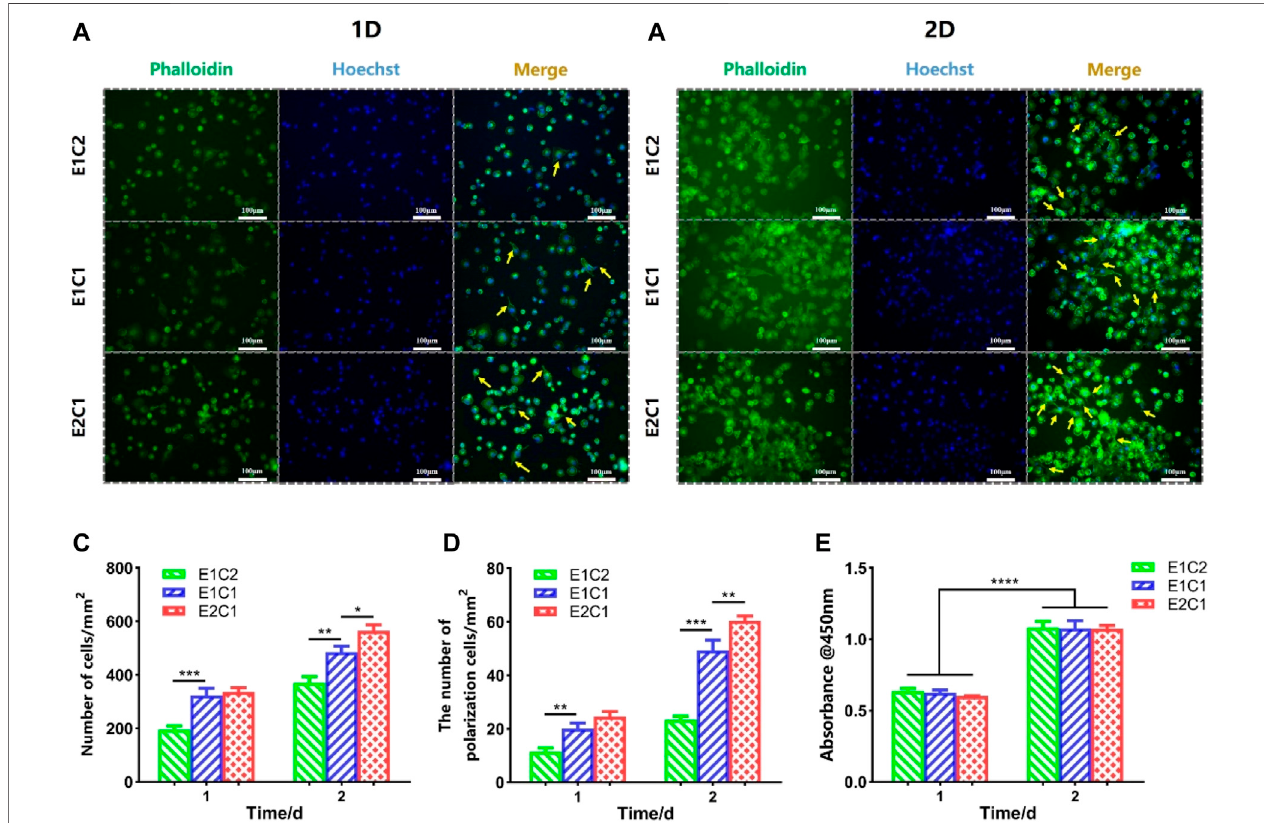
FIGURE10| Growth ofRSC96 cellsunderthein fl uence ofNDM-CSscaffolds. Immuno fl uorescence stainingofRSC96 cells cultured for (A) 1 day and (B) 2 days. (C) ThenumberofSchwanncellsindifferentgroups. (D) Thenumberofpolarizedcellsindifferentgroups. (E) CellviabilityofSchwanncellsondifferentscaffoldsof1and 2 days. Scale bars represent 100 μ m* p < 0.05, ** p < 0.01, *** p < 0.001, **** p <